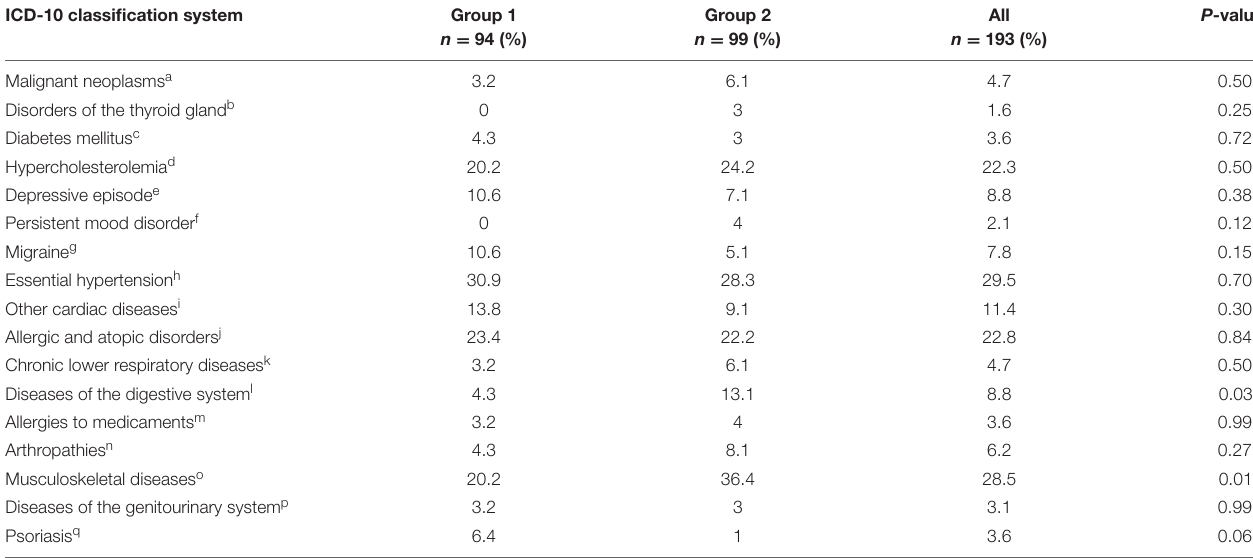
TABLE 1 | Distribution of diseases reported by the 193 male participants born in 1953. ICD-10 classification system